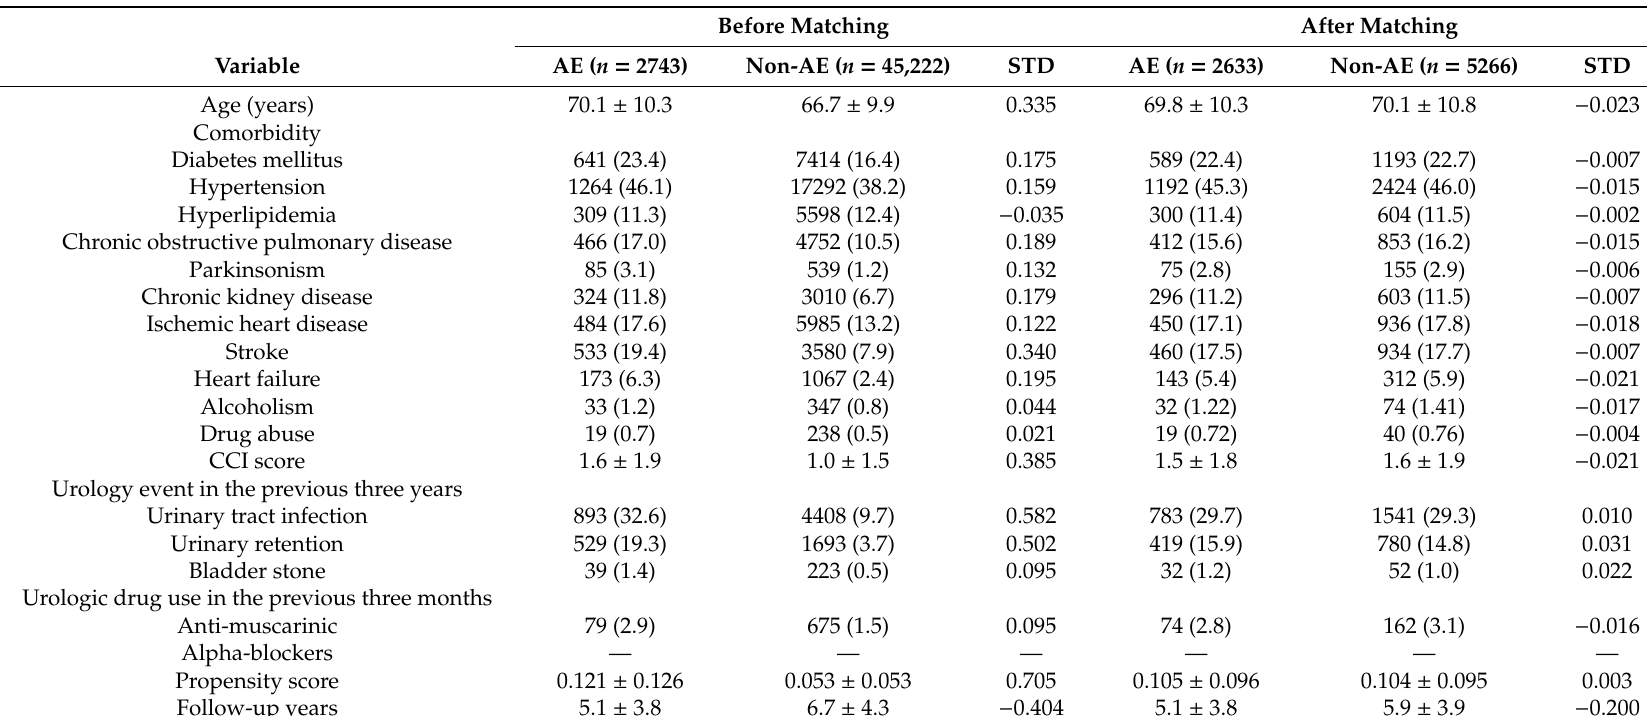
Table 6. Baseline characteristics of patients with BPH who received alpha blocker therapy grouped according to the presence or absence of AEs during the six-month follow-up